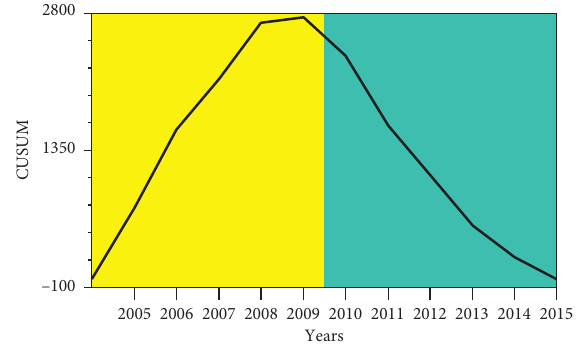
Figure 3: KwaZulu-Natal: CUSUM plot. Table 4: Table of significant changes for murder in KwaZulu-Natal. Years Confidence interval Conf. level From